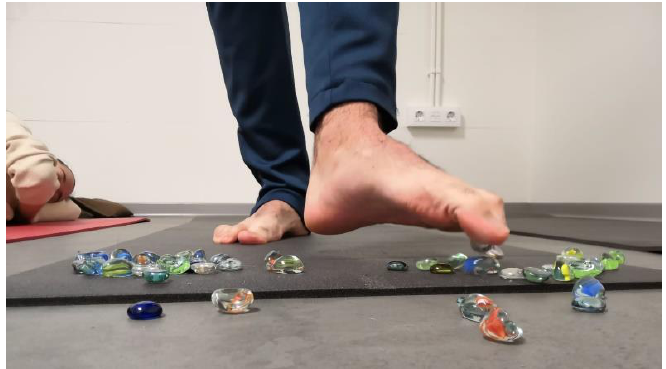
Figure 1. Picking up small glass stones using toes and depositing the stones elsewhere.